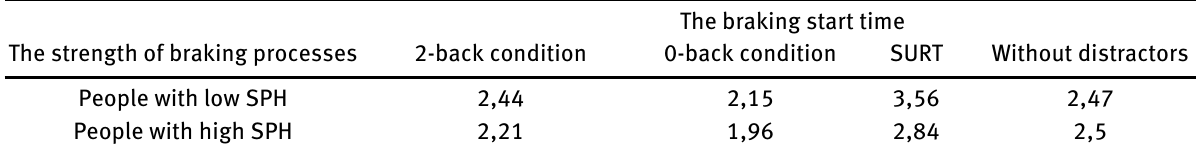
The braking start time